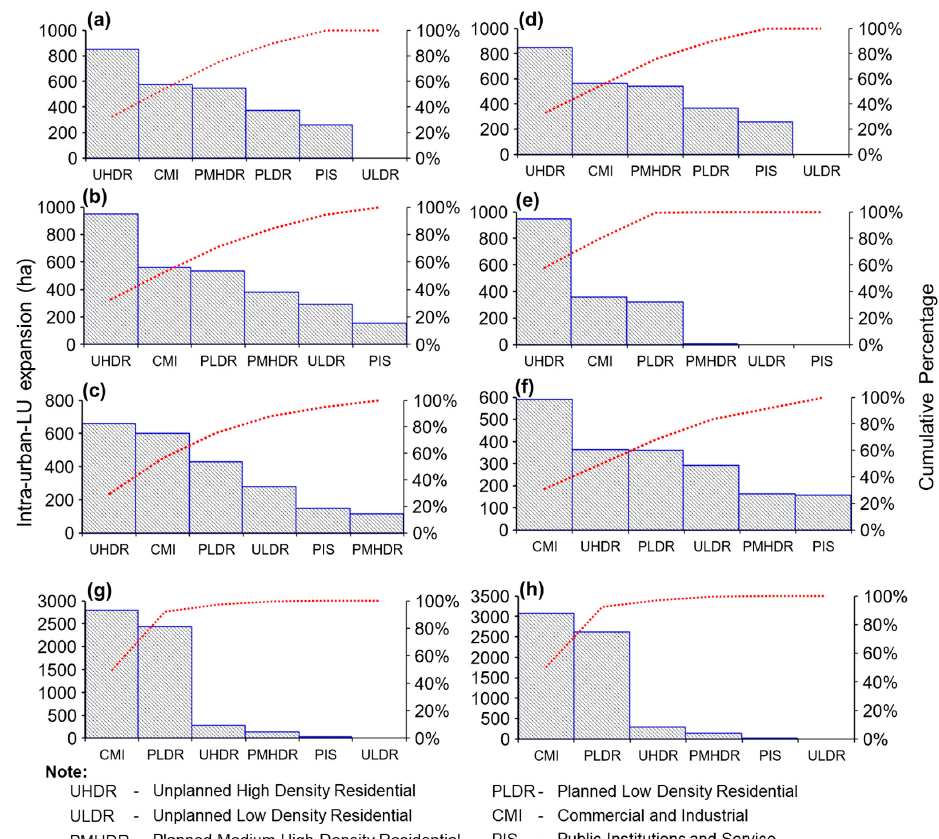
Figure 7. Pareto analysis charts identifying simulated urban-LU classes that would significantly contribute to the total urban-LU expansion for Lusaka city, Zambia. Scenario 1: ( a ) 2015–2020, ( b )